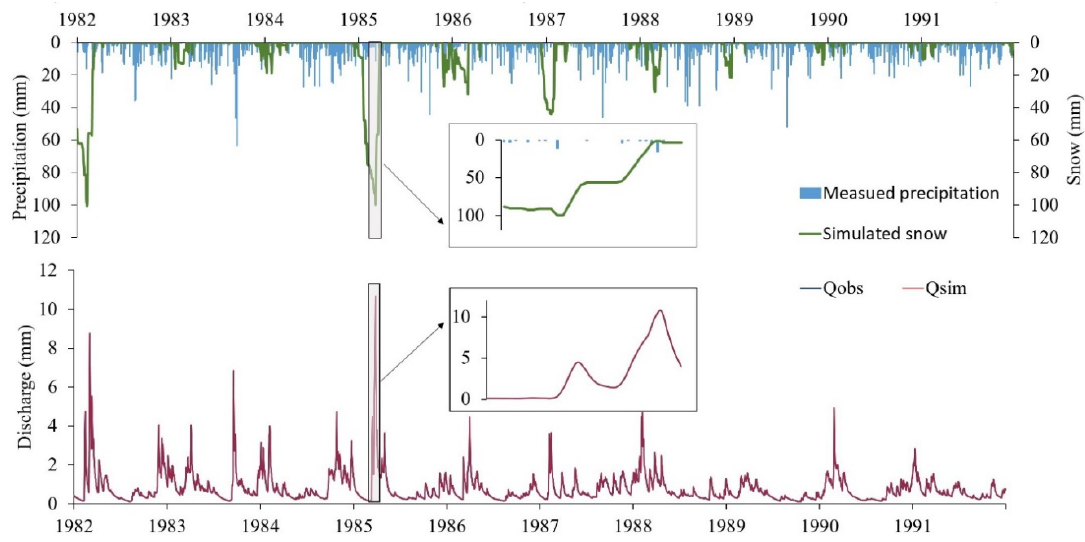
Figure 2. Observed and simulated discharges with the Gauss–Levenberg–Marquardt method (GLM) calibration procedure for the calibration period from 1 January 1982 to 31 December 1991. Table 4. Calibration results 1 from history matching of the synthetic model over ten years, i.e., 1 October 1981 to 31 December